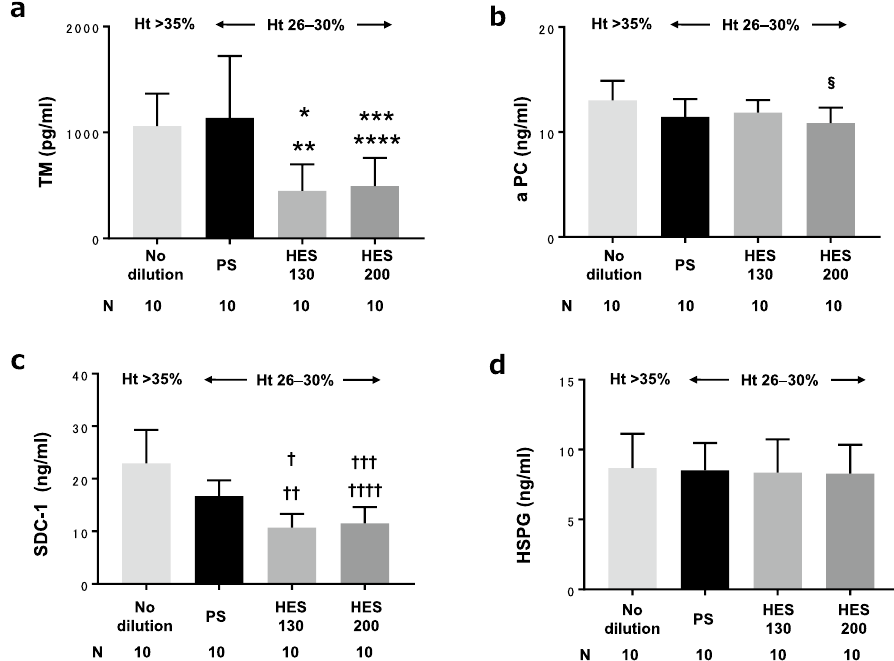
Figure 4. Quantification of Quantification of ET and GCX damage markers by ELISA. ET, endothelium; GCX , glycocalyx; ELISA , enzyme-linked immunosorbent assay; TM , thrombomodulin; aPC , activated protein C; SDC - 1, syndecan-1; HSPG , heparan sulfate proteoglycan. *P = 0.008 vs no-dilution, **P = 0.003 vs PS, ***P = 0.016 vs no-dilution, ****P =0.005 vs PS, § P= 0.021 vs no-dilution, † P = 0.0009 vs no-dilution, †† P = 0.018 vs PS, ††† P = 0.003 vs no-dilution, †††† P = 0.045 vs